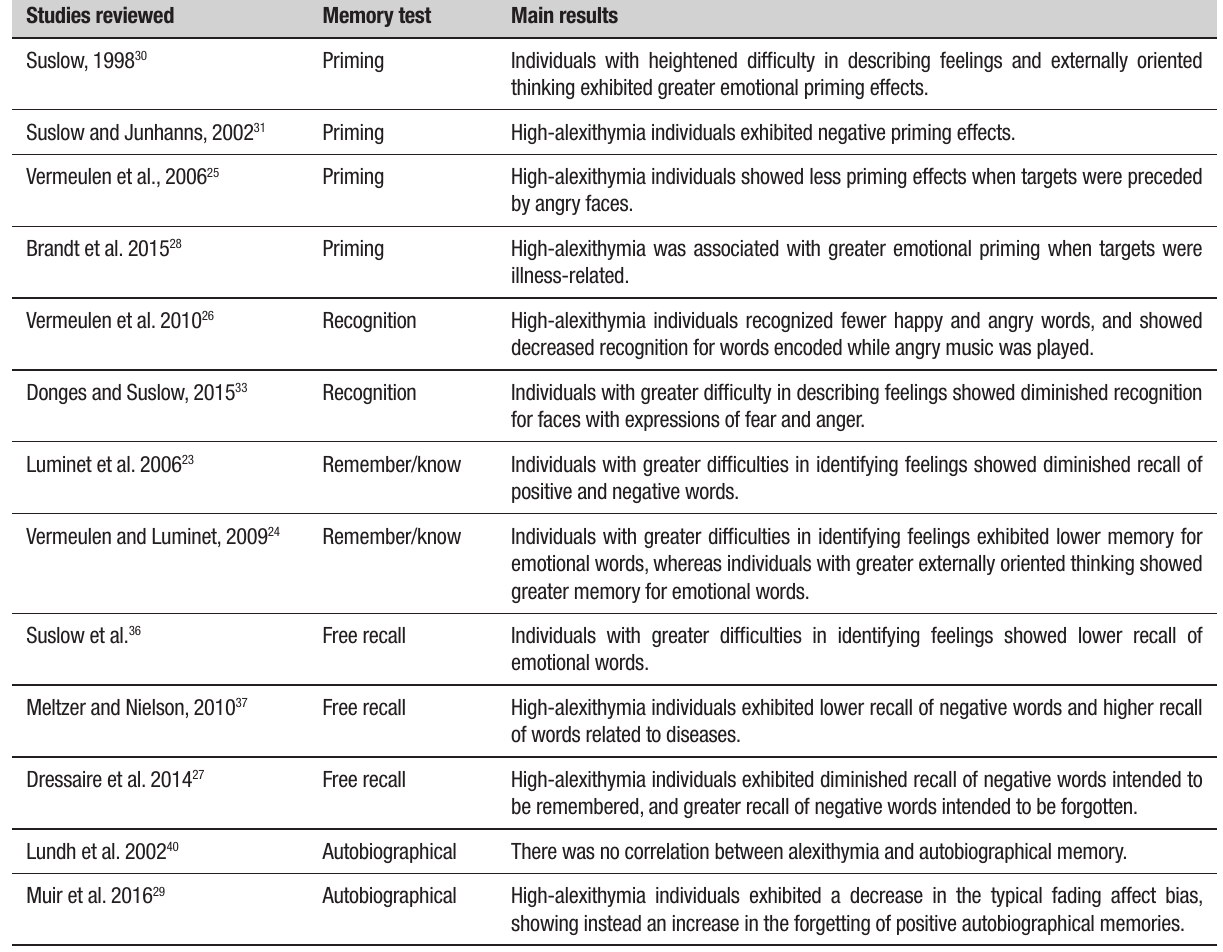
Table 1. Memory tests adopted by the reviewed studies and their respective main